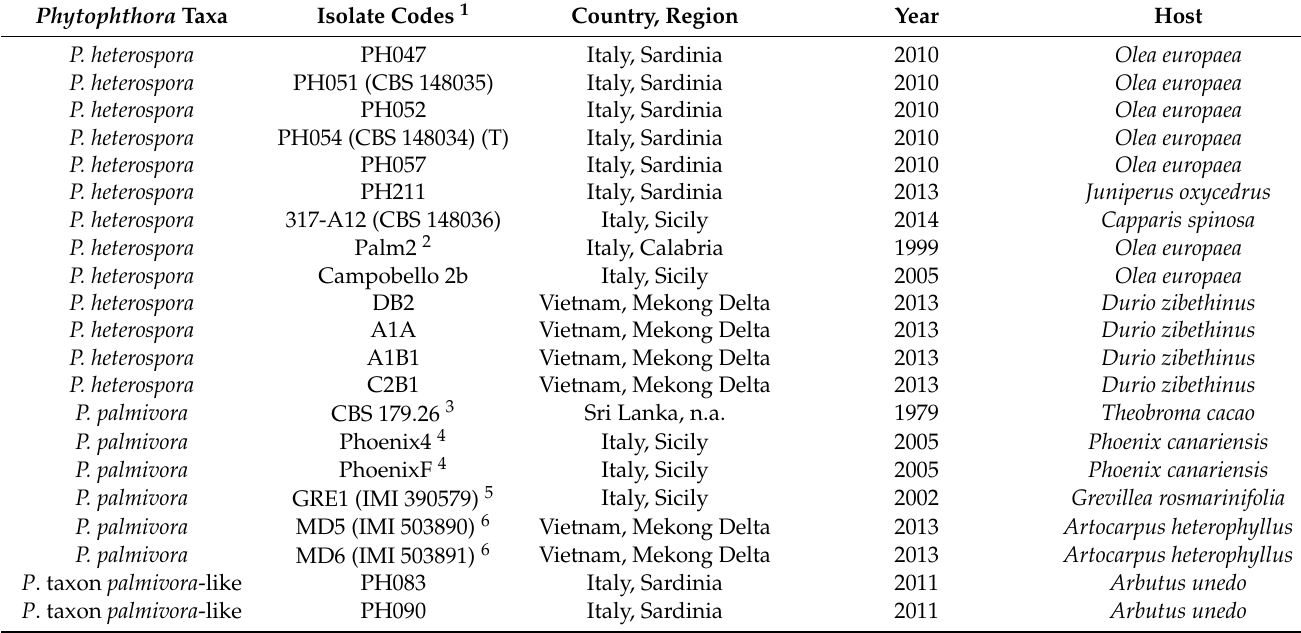
1 Abbreviations of isolates and culture collections: CBS = Centraalbureau voor Schimmelcultures, Utrecht, Netherlands; IMI = CABI Bioscience, United Kingdom; other isolate names and numbers are as given by the collectors; T = ex-type culture. 2 Isolate from Cacciola et al. [12]. 3 Isolate from Brasier and Griffin [18]. 4 Isolates from Pane et al. [19]. 5 Isolate from Cacciola et al. [20]. 6 Isolates from Van Tri et al.